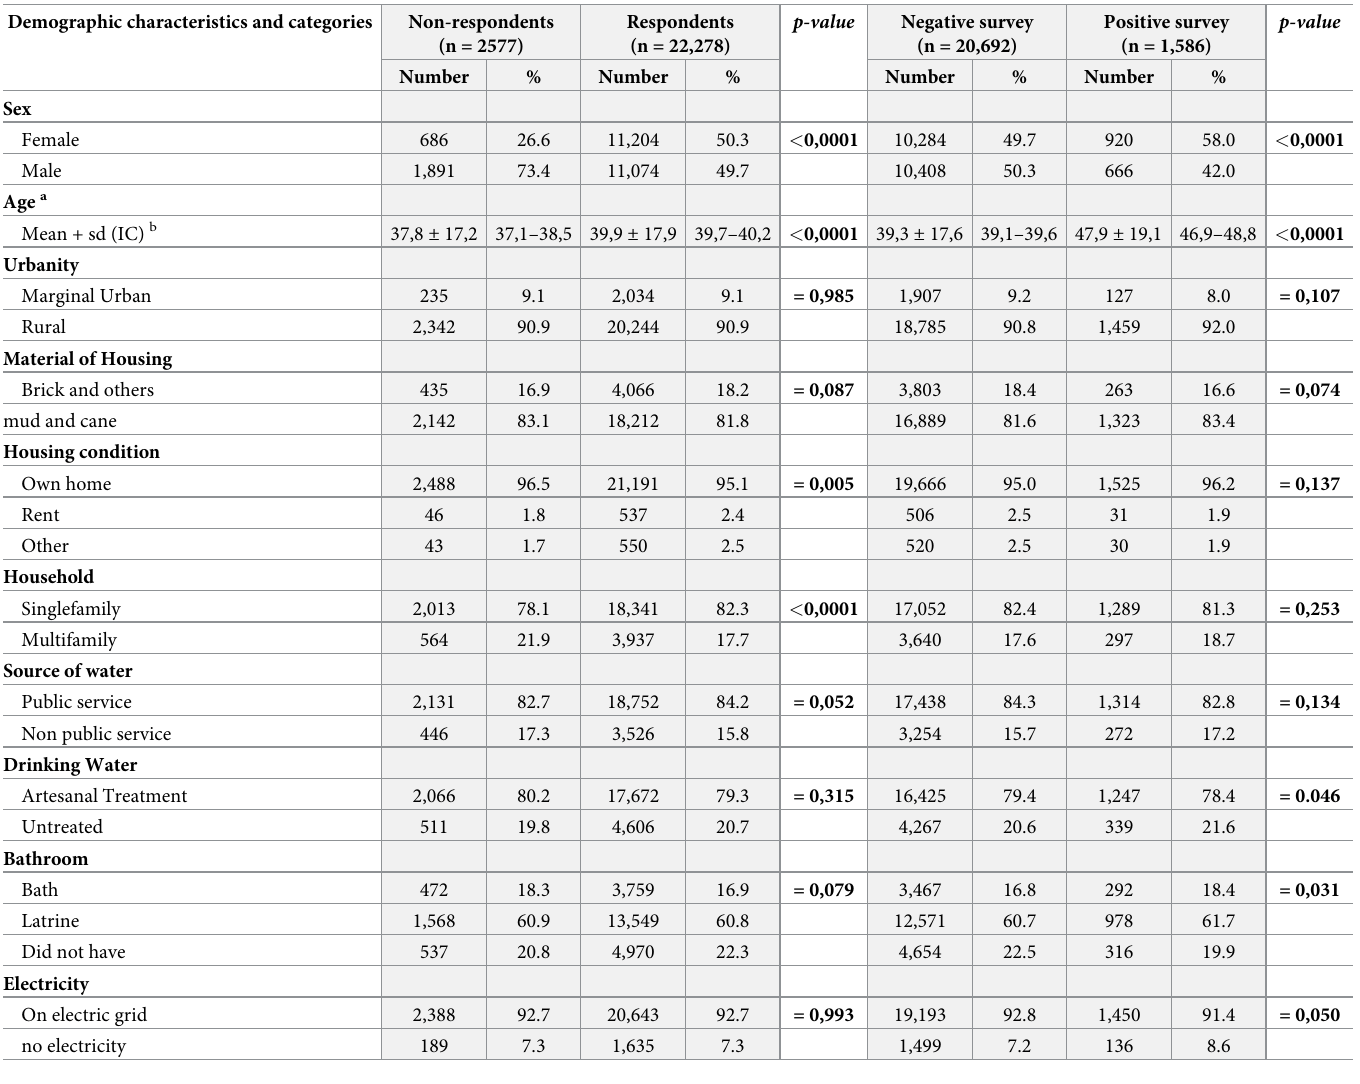
Table 1. Demographic characteristics of respondent’s vs non-respondents and between negative and positive individuals surveyed for stroke. Demographic characteristics and